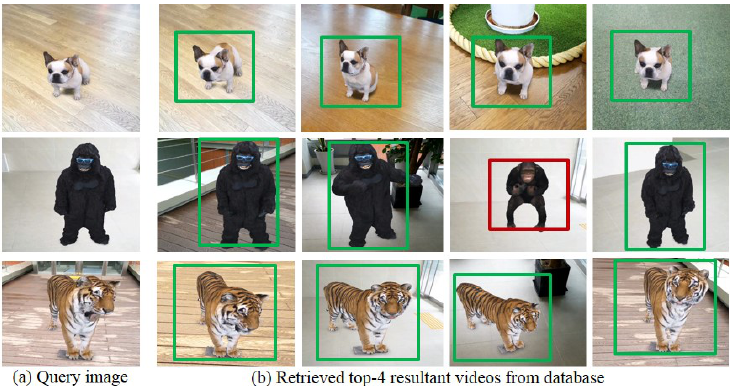
Figure 14. Retrieval results for AVD8 dataset: ( a ) Query image and ( b ) Retrieved top-4 resultant videos from